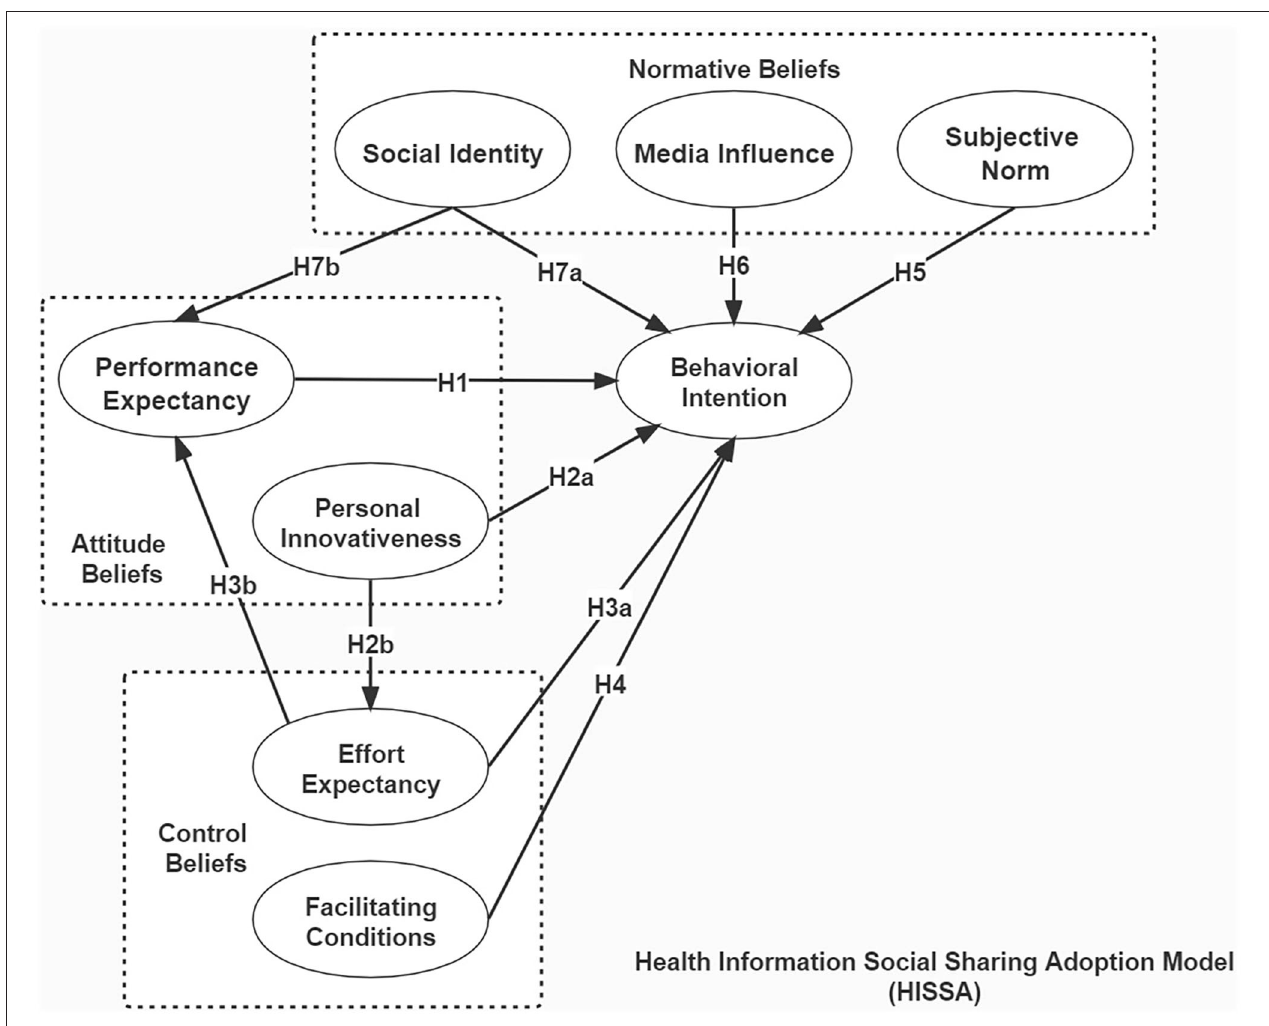
FIGURE 2 | The hypothesized model of health information social sharing adoption